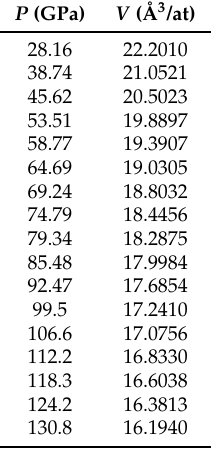
Figure 2. Volume of hcp-Pb volume measured in this study and from the literature [19,21,22]. Inset: c / a ratio measured in this study. Table 2. Pressure P (from ruby luminescence, with calibration from [4]) and volume V (measured with X-ray diffraction) for hcp-Pb. The data are listed in the order they have been taken. P (GPa) V (Å 3